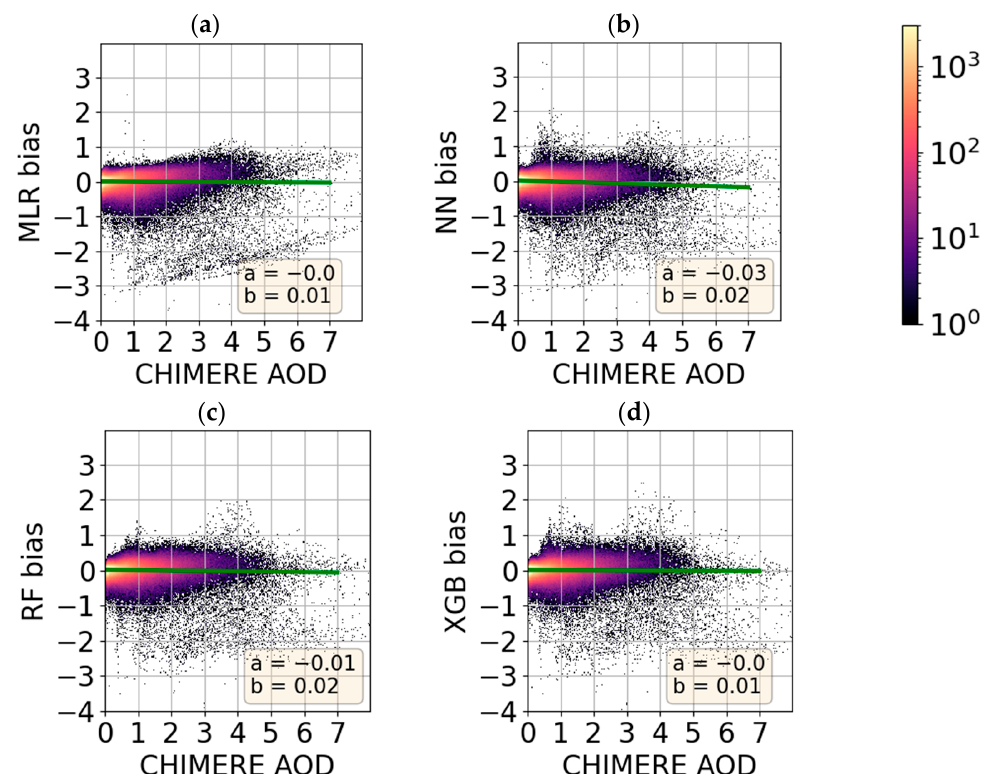
Figure 9. Scatterplots showing the AOD biases amplitudes corrected by the following ML models: ( a ) MLR, ( b ) NN, ( c ) RF, and ( d ) MLR, with respect to the a priori AODs (raw CHIMERE AOD 550 estimates) for D Test . The green line represents the linear fit with a slope a and the intercept b. Colormap represents the occurrence.